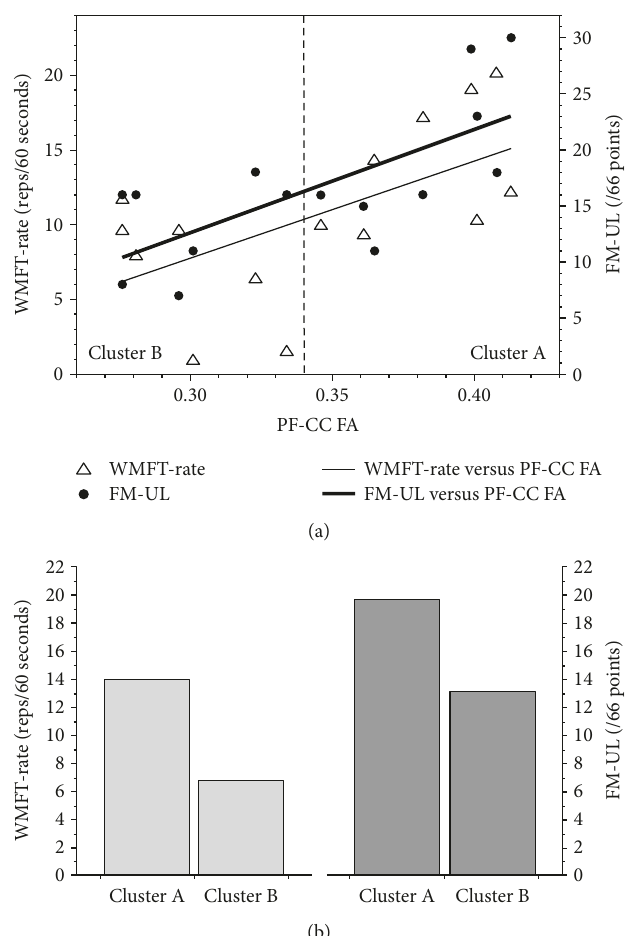
Figure 4: (a) From the group of individuals with severe arm impairment ( n = 15 ), k-means cluster analysis of PF-CC FA identi fi ed two groups: cluster A, higher outcome, and cluster B, lower outcome. (b) Between group di ff erences for cluster A and cluster B were signi fi cant for function (Wolf Motor Function Test rate (WMFT-rate), p = 0 006 ) and impairment (Fugl-Meyer upper limb (FM-UL), p = 0 049 ). PF-CC: prefrontal corpus callosum; FA: fractional anisotropy; WMFT-rate: Wolf Motor Function Test rate; FM-UL: Fugl-Meyer upper